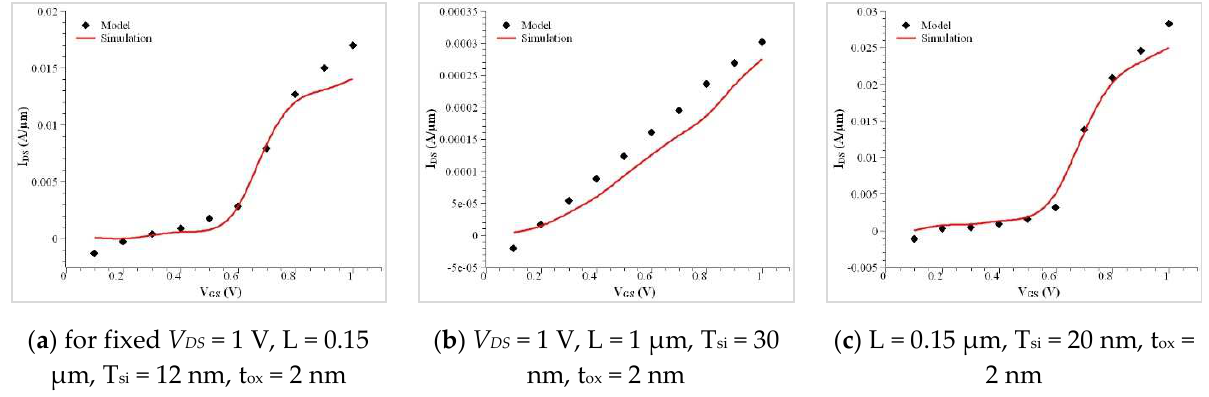
Figure 7. Comparison of doped channel of symmetrical FET between measurements and simulation outputs; I DS versus V GS in the CSDG MOSFET.